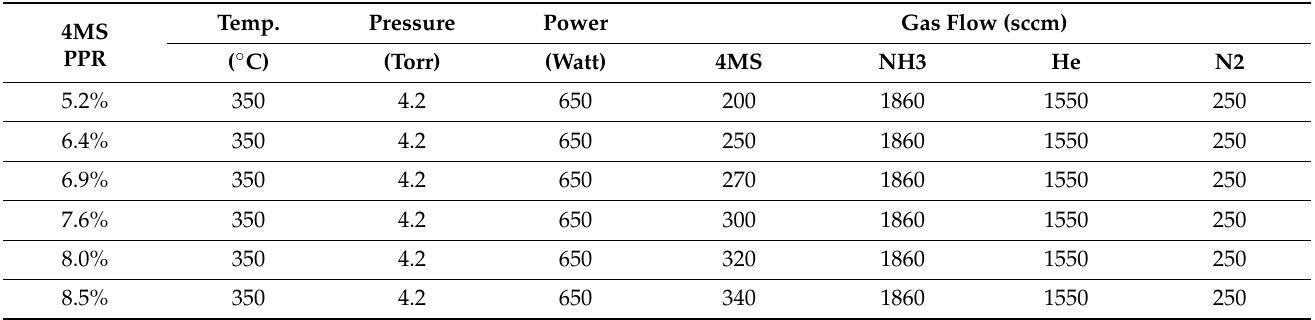
Table 1. Process conditions of SiCN films deposited using four gases (4MS, NH 3 , He, and N 2 )